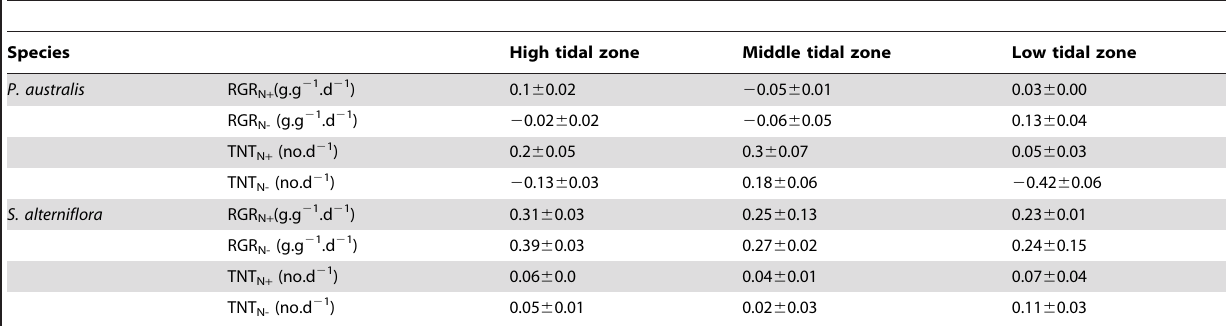
Table 3. The relative growth rate per day (RGR) and the number of newly produced tillers per day (TNT) responses of S. alterniflora and P. australis to neighbor removal in different tidal zones (mean 6 SE).